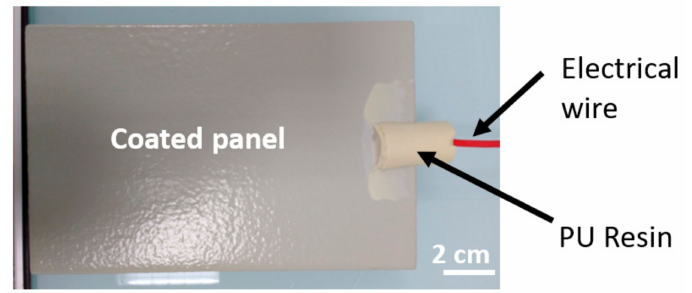
Figure 1. Coated panel with electrical